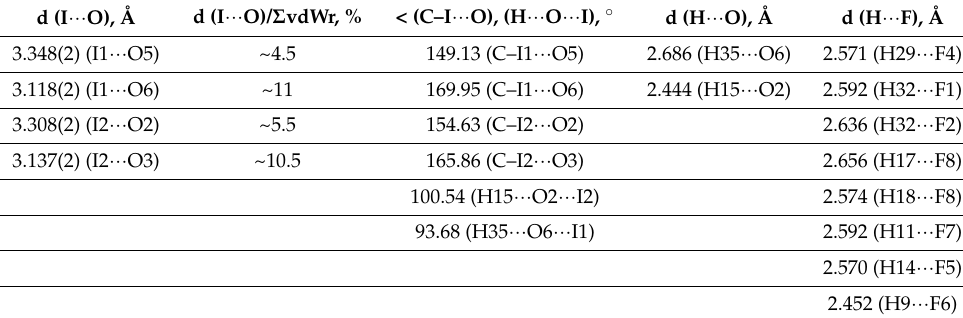
Table 2. Parameters of halogen and hydrogen bonds in I–azo–NO 2